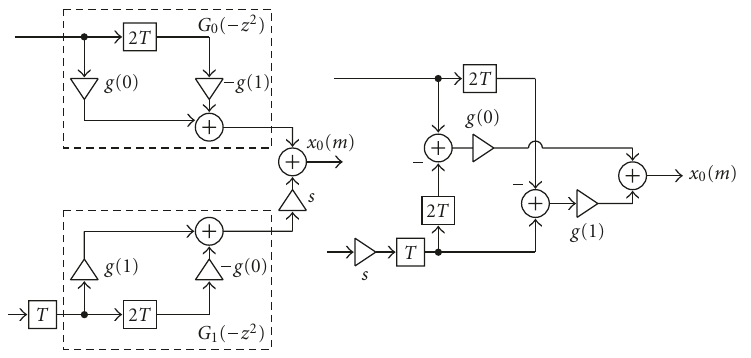
Figure 5: Sharing of multipliers between G 0 ( − z 2 ) and G 1 ( − z 2 ) in the 0th channel when N G =